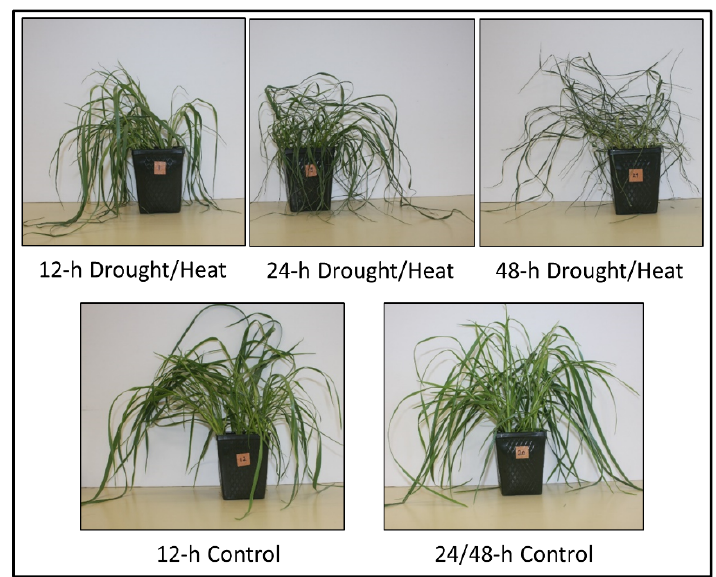
Figure 1. Images of representative Lolium temulentum plants after being exposed to heat/drought stress conditions for 12, 24, or 48 h ( top panel ) and control plants at 12 and 24/48 h ( bottom panel ).